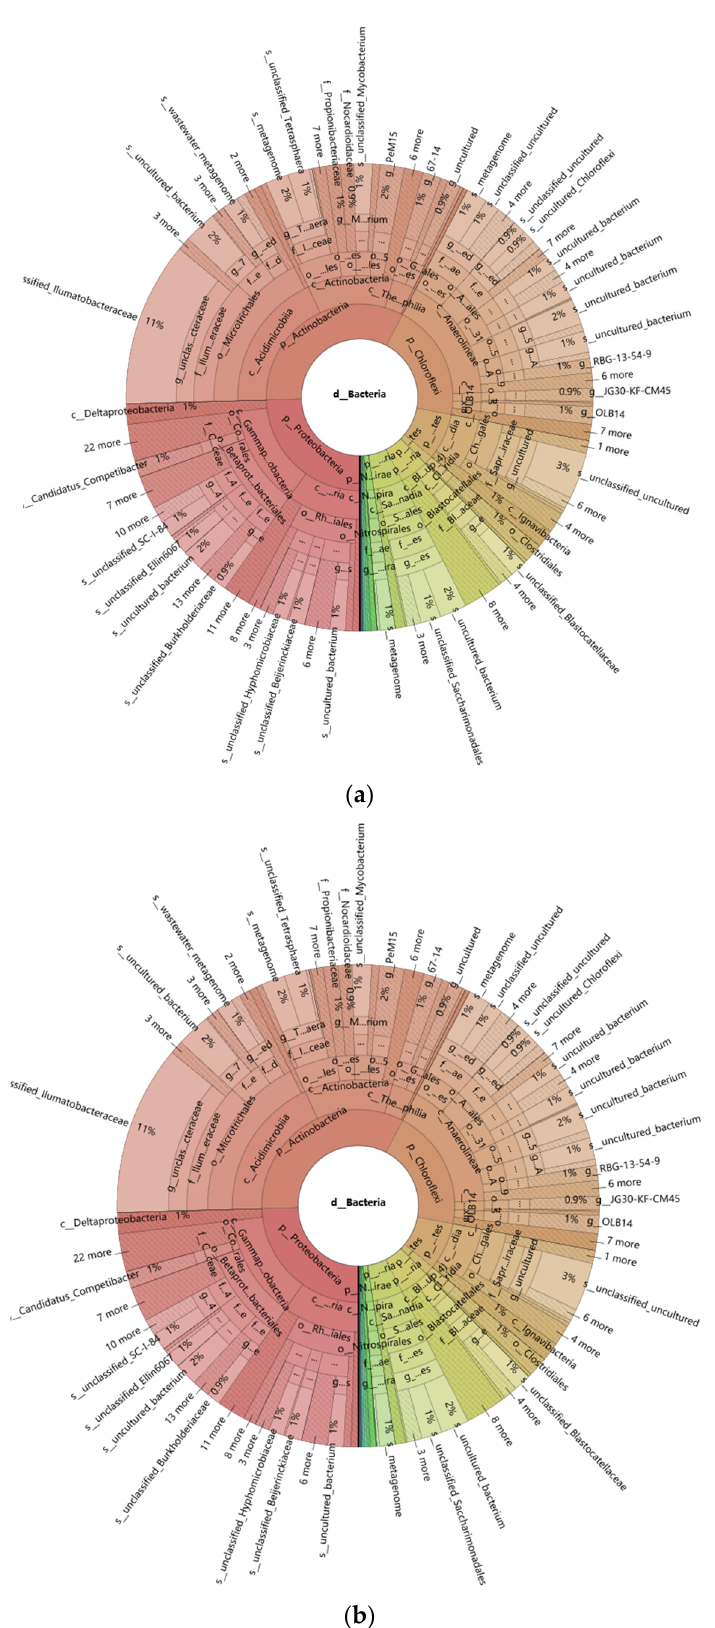
Figure 9. Community structure and relative abundance of microorganisms before domestication ( a ). Community structure and relative abundance of Proteobacteria microorganisms before domestication ( b ).